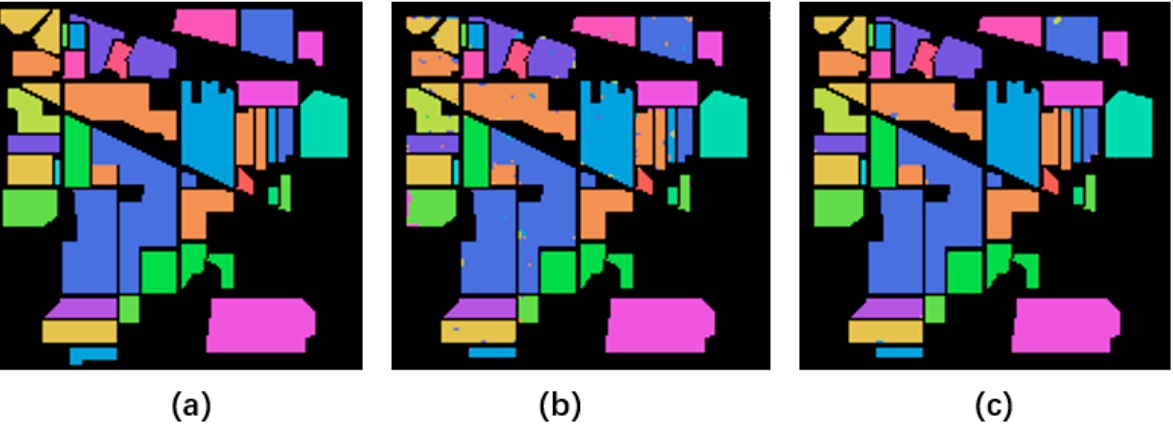
Figure 11. Classification results on the Indian Pines dataset. ( a – c ) represent category labels of ground truth, classification result on degraded data, and classification result after quality enhancement, respectively.